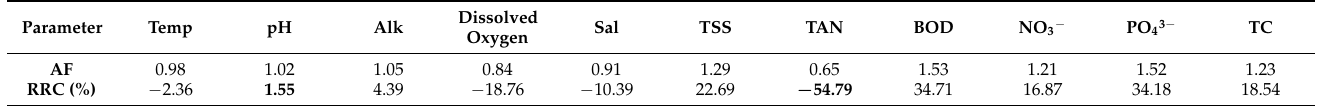
Table 3. Accumulation factor and river recovery capacity for water quality parameters of the Hau River. Parameter Temp